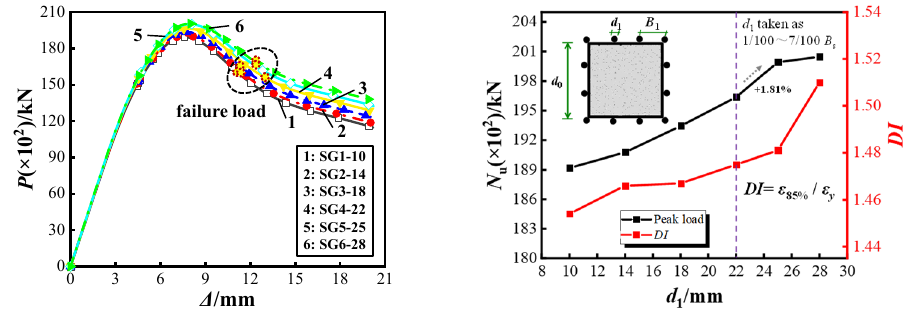
Figure 22. Load–displacement curves for different reinforcement diameters.